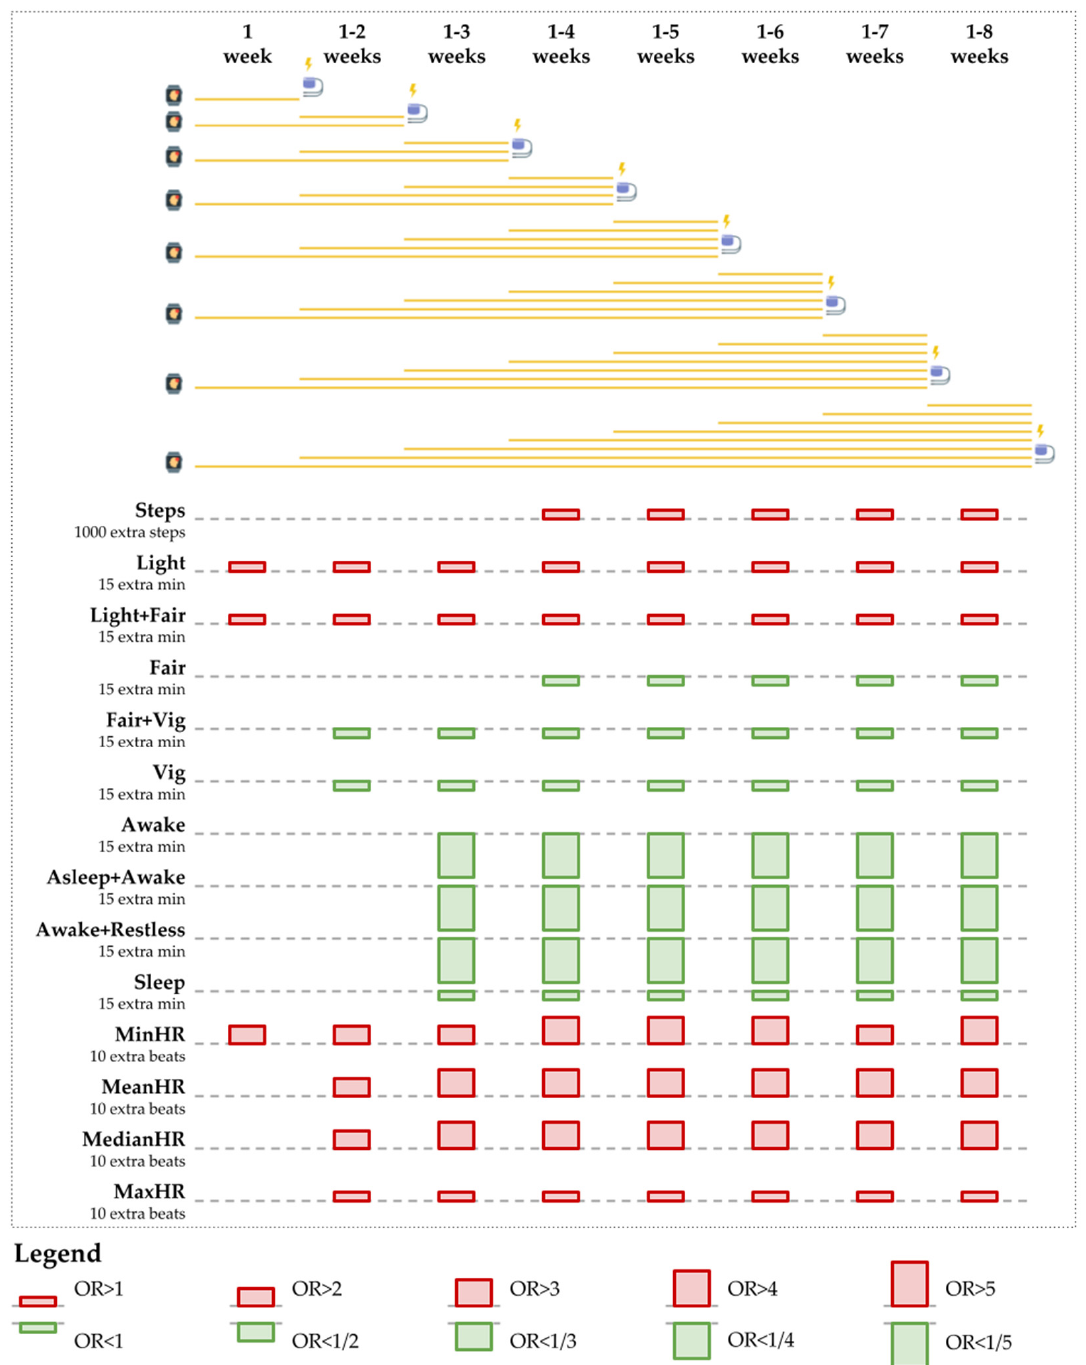
Figure 6. Odd ratios obtained from the combined models for 1000 extra steps, 15 extra minutes of physical activity or sleep, and 10 extra beats per minute for the heart rate. The combined Fitbit measurement periods of 1, 1–2, . . . , 1–8 weeks are depicted on top. Below, informative estimations of the odd ratios are represented. For all results, p < 0.05. All periods in the combined models (depicted in yellow as sequences of weeks and stacked for each maximum duration of 1, 2, . . . , 8 weeks) are followed by potential events (depicted at the end of the yellow sequences). ORs are depicted as bars: OR > 1 (red and upwards) and OR < 1 (green and downwards). Bar height corresponds to the distance between the OR and 1.